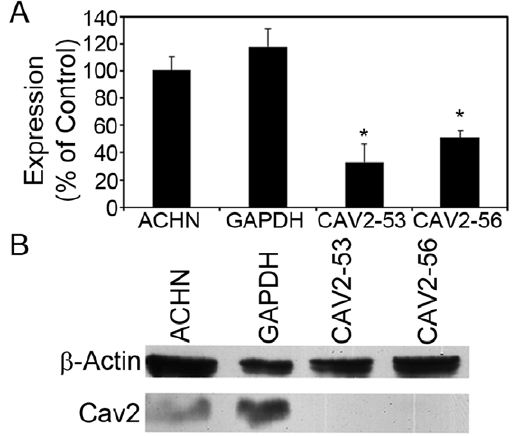
Figure 2. Caveolin 2 expression knockdown by shRNA. A) ACHN cells were stably transfected with gene-specific shRNA to GAPDH , or CAV2 (CAV2 – 53 and CAV2 – 56). Quantitative real-time PCR was used to determine the relative amount of CAV2 mRNA in transfected and non- transfected ACHN cells. Results of triplicate samples are shown and are expressed relative to non-transfected ACHN cells. The asterisk denotes results that are significantly different from non-transfected ACHN cells (p , 0.05, ANOVA followed by Dunnett’s post hoc test). B) Whole-cell lysates from non-transfected and stably transfected ACHN cells were immunoblotted with anti-CAV2 antibody; anti- b -actin antibodies were used as a loading control. A representative immunoblot is shown.